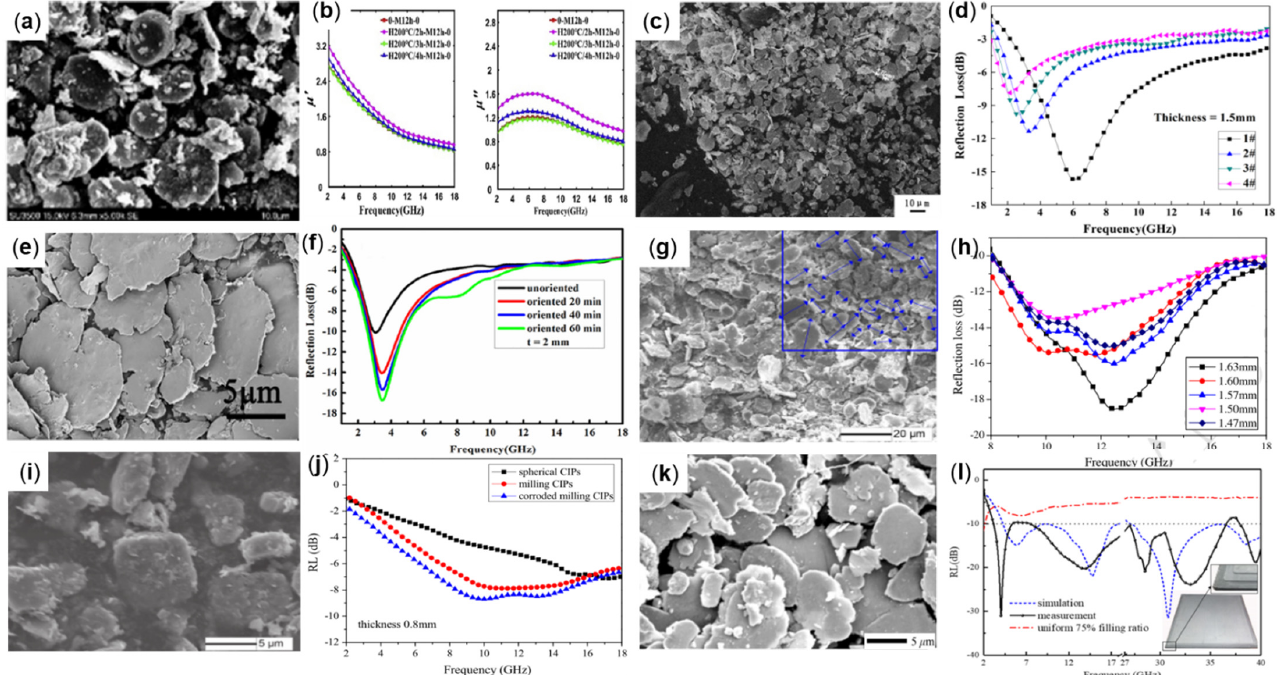
Figure 4. ( a ) SEM and ( b ) magnetic permeability plot of FCI, reproduced with permission from